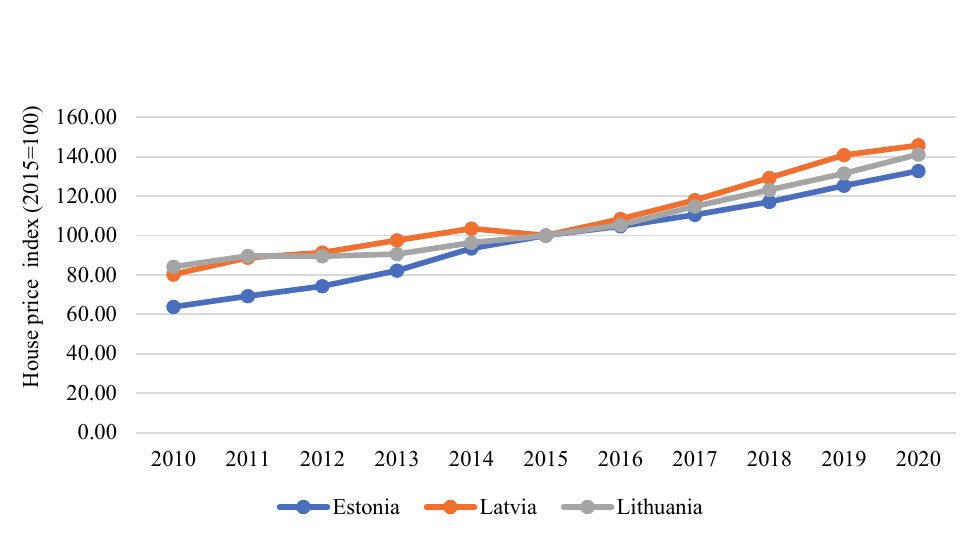
Fig. 4. House price index – annual data for 2010 – 2020 – annual average index– total, in Estonia, Latvia and Lithuania (2015 = 100) (developed by the authors based on European Statistics Database Eurostat).